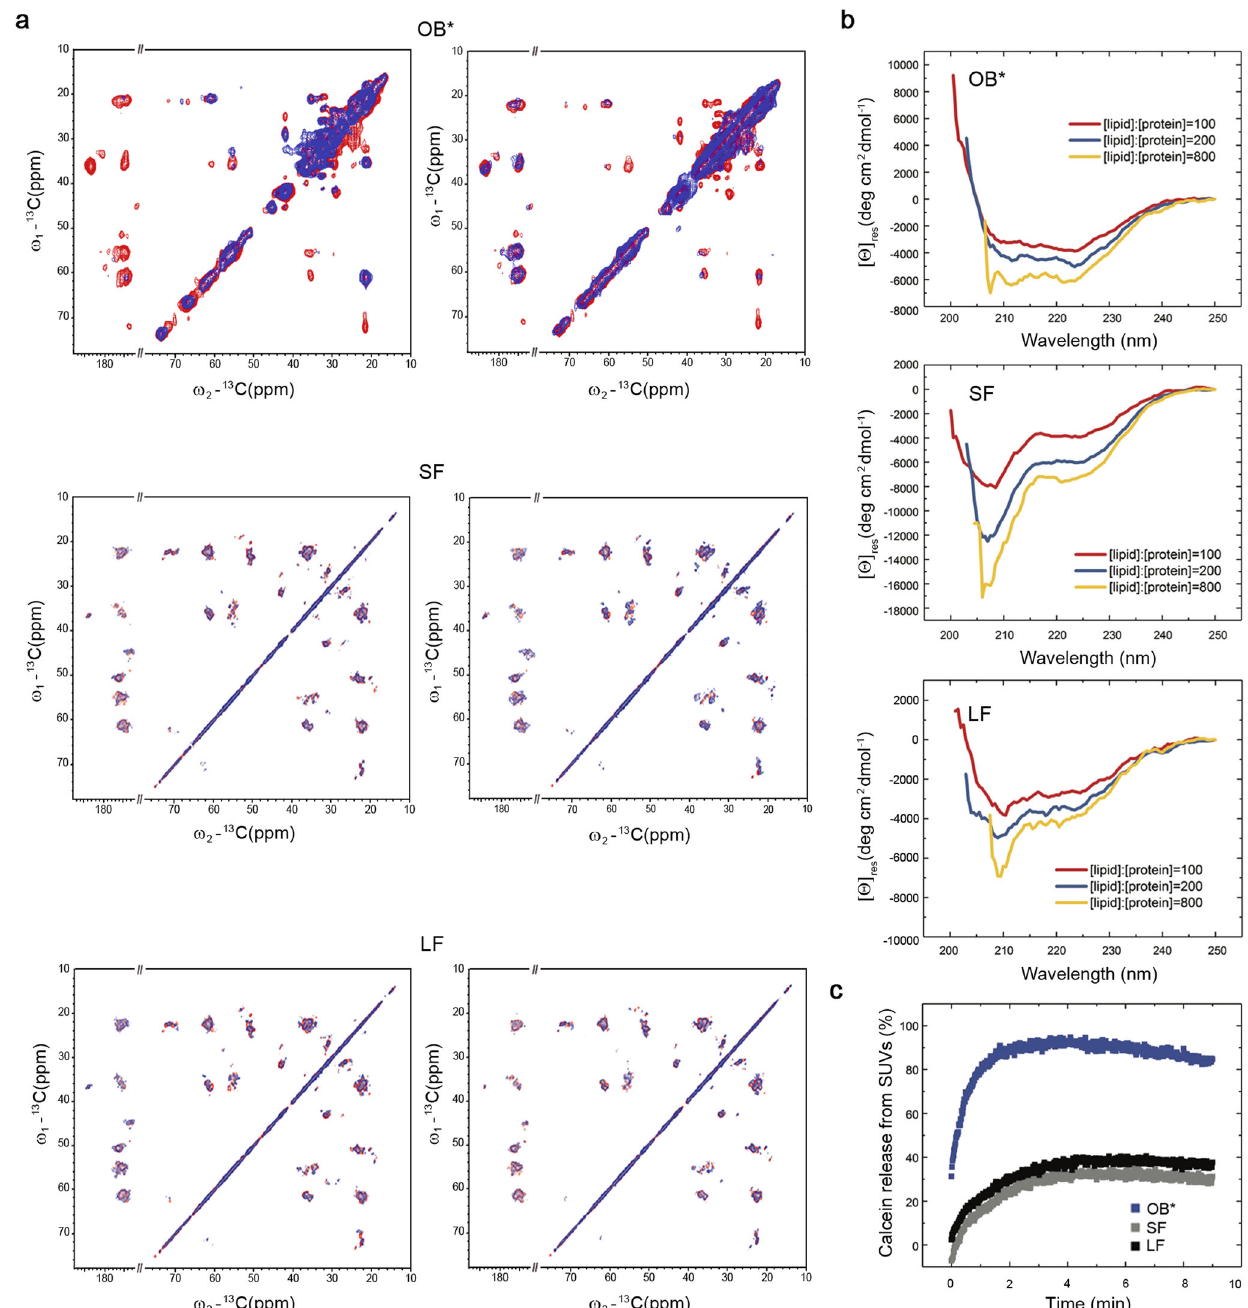
Fig. 1 α S fi brils interact weakly with the surface of the lipid bilayer of synthetic membranes. a PRE effects measured using MAS ssNMR for OB*/SF/LF using SUVs with DOPE:DOPS:DOPC lipid composition (molar ratio of 5:3:2) with a paramagnetic center (PC) on the bilayer surface on the hydrophilic head group (left) or in the membrane interior at carbon 16 of the lipid chain (right). 13 C – 13 C DARR spectra measured in the presence and absence of the PC- labeled lipids are shown in blue and red, respectively. For comparison, the plots of OB* are drawn using OB* data from our previous investigation 8 . b Changes in the far-UV CD spectrum of 10 μ M OB*/SF/LF and increasing concentrations of SUVs: 1 mM (red), 2 mM (blue), and 8 mM (yellow). The spectra in the absence of SUVs was subtracted in each case from that acquired in their presence. c Calcein release from SUVs (% of total intravescicular calcein — signal normalized with respect to the treatment with 1% v/v Triton X-100, see Supplementary Information for more details) upon incubation of the vesicles with the indicated α S of maximum release at the fi rst time point of measurement, and reaching the maximum level (ca. 90% of maximum release) after 2 min of incubation at a protein:lipid ratio of 1:100. SF/LF caused, however, a much slower and very signi fi cantly reduced calcein release (ca. 30% release after 5 min) under identical conditions (Fig. 1c).